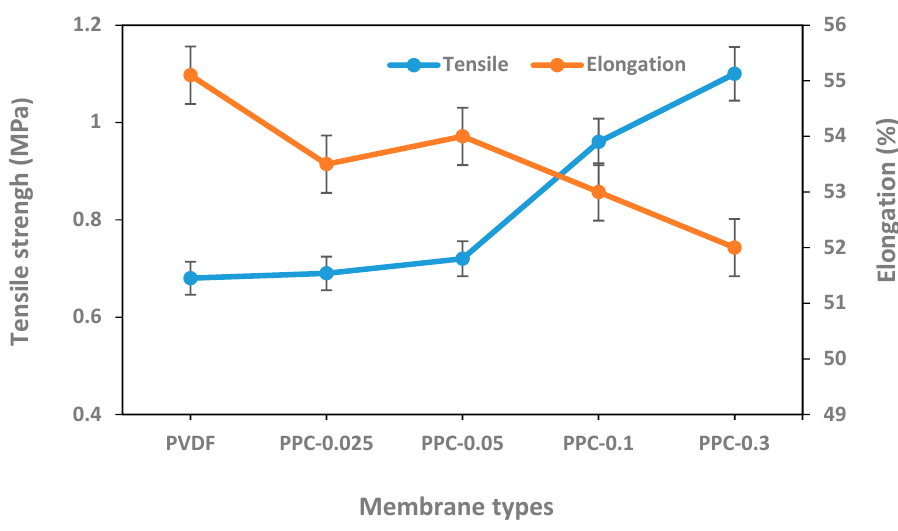
Figure 8. Tensile strength and elongation at break for pristine and modified membranes.